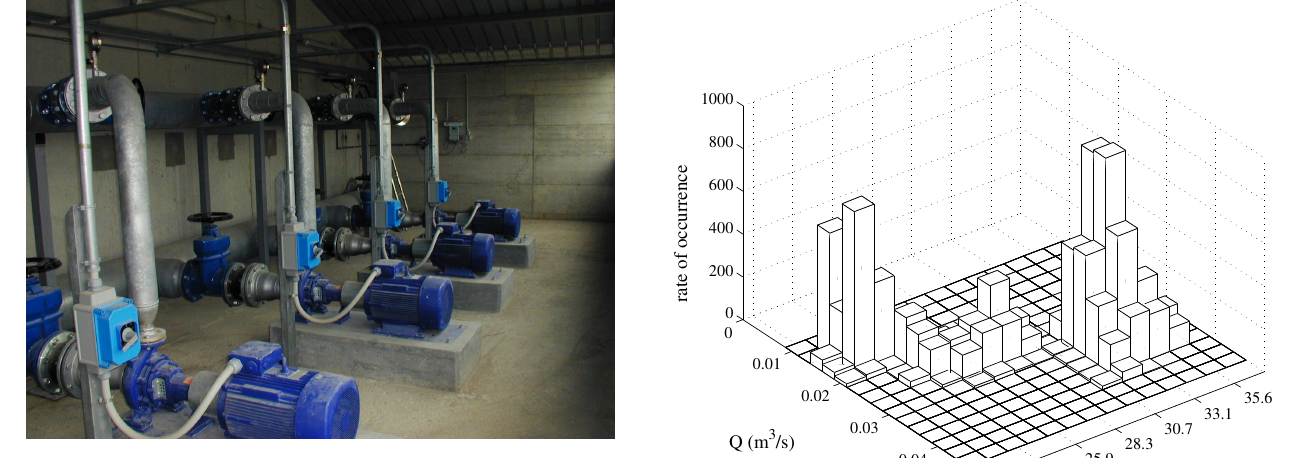
Figure 1. Casale pumping station: the four pumps in parallel.